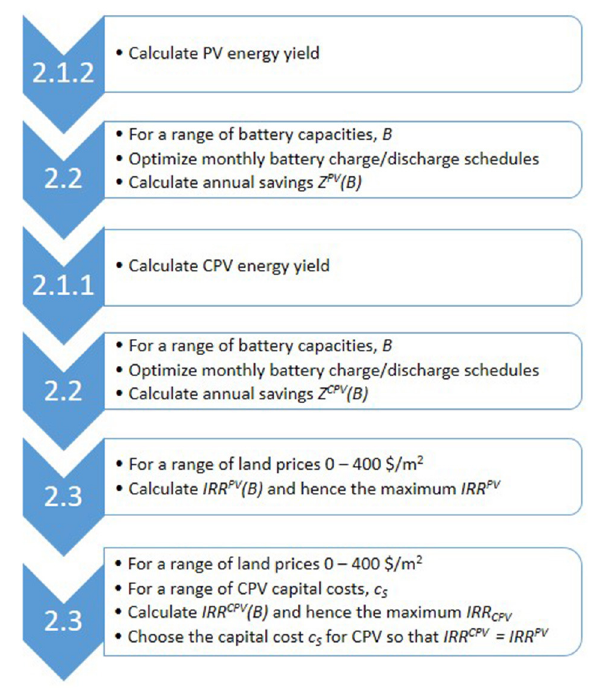
FIGURE 2 | Sequence of calculations from different subsections of section Energy and Economic